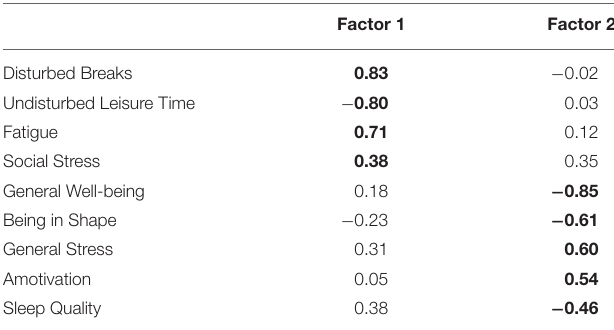
TABLE 5 | Exploratory factor analysis for a two factor solution for the sample of study